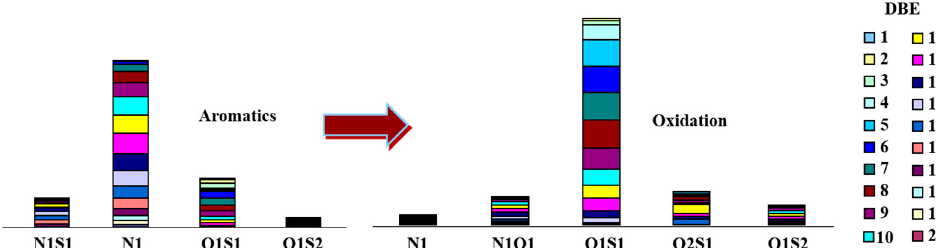
Figure 3. Broadband and mass scale expanded ESI FT-ICR mass spectrum of aromatics and oxidation sulfides.